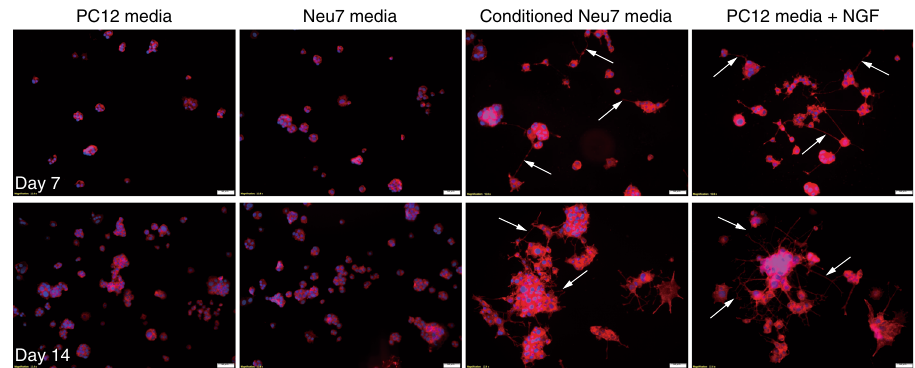
Fig. 10 Fluorescent images of PC12 after incubation with different media. Arrows indicate the outgrowth of neurite. The cell nucleus were stained with DAPI (blue), F-actin was stained with Alexa Fluor 594 (red). The scale bars represent 50 μ